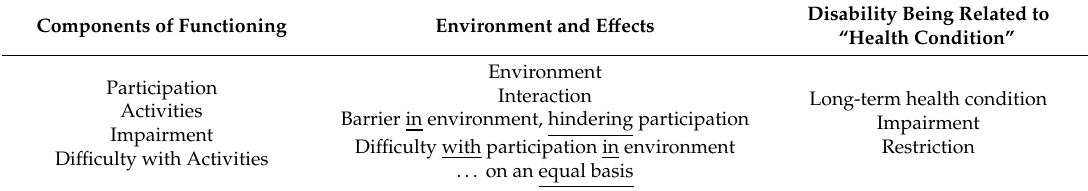
Table 3. Key concepts of disability that support data comparability, for use in